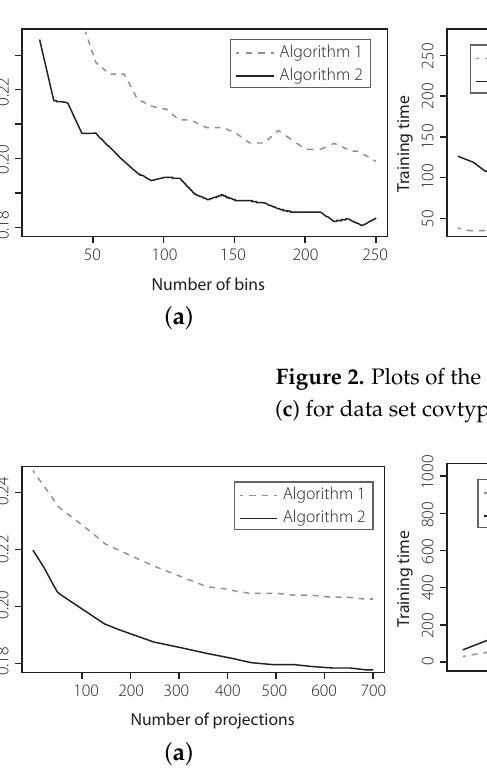
Figure 1. Histograms of Directed projections and Random projections algorithms (Algorithms 1 and 2). Data sets covtype.binary ( a ) and a9a ( b ).